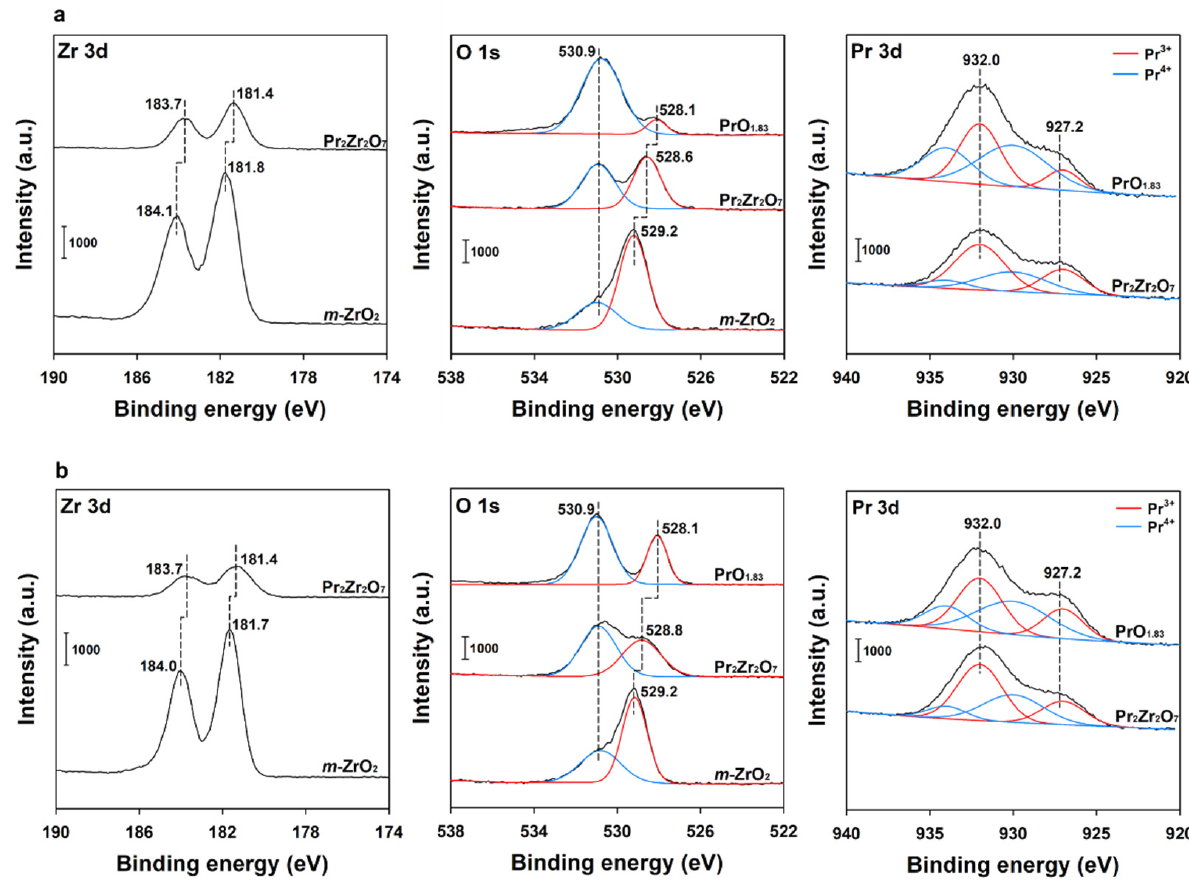
Figure 2. XPS spectra of ( a ) support materials and ( b ) supported Cu catalysts. Each panel represents the regions of Zr 3d ( left ), O 1s ( middle ), and Pr 3d ( right ). To confirm the presence of oxygen vacancy, Raman spectra were acquired for